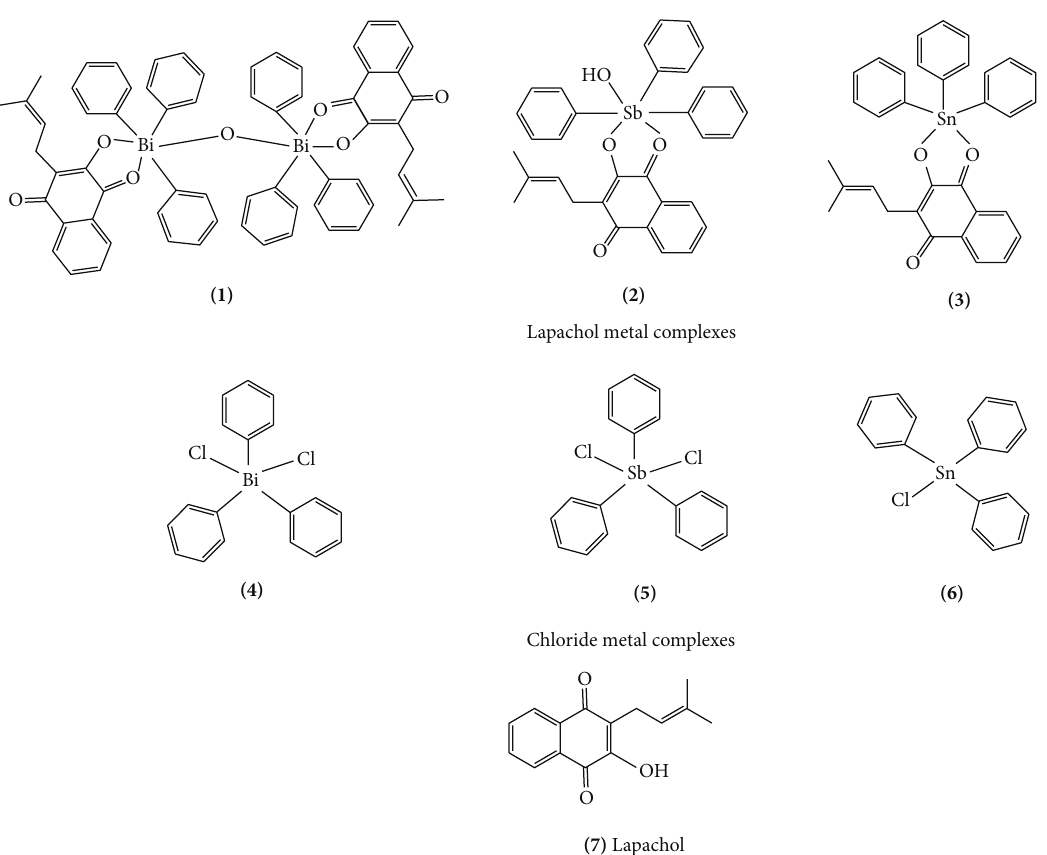
Figure 1: Structures of lapachol metal (Bi, Sb, and Sn) complexes ( 1 – 3 ) and chloride metal (Bi, Sb, and Sn) compounds ( 4 – 6 ) and lapachol ( 7 ). Legend: Bi = bismuth, Sb = antimony, and Sn =